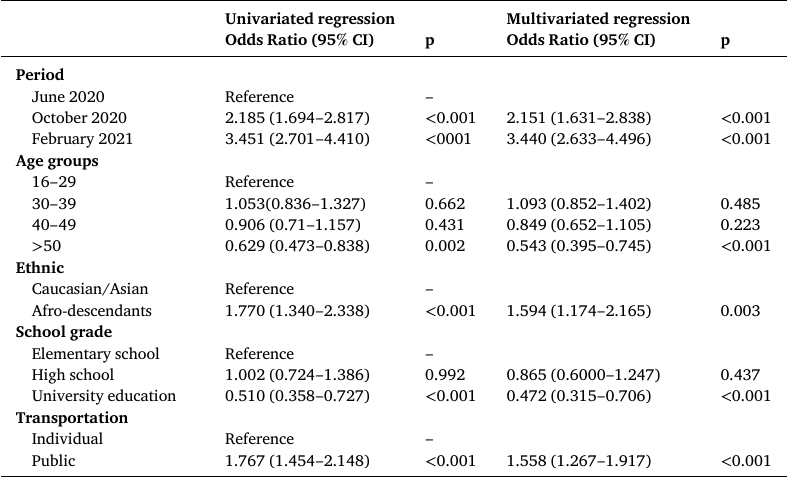
Table 2 Univariate and multivariate logistic regression analysis to predict the presence of anti-SARS-CoV-2. Univariated regression